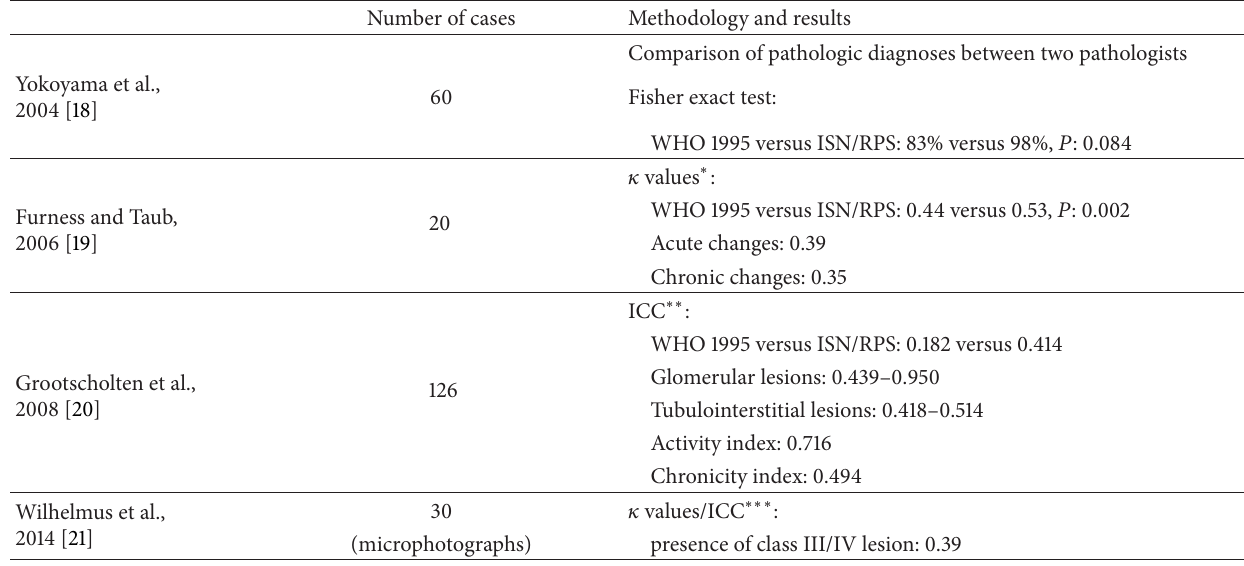
Table 3: Interobserver validation studies in lupus nephritis.